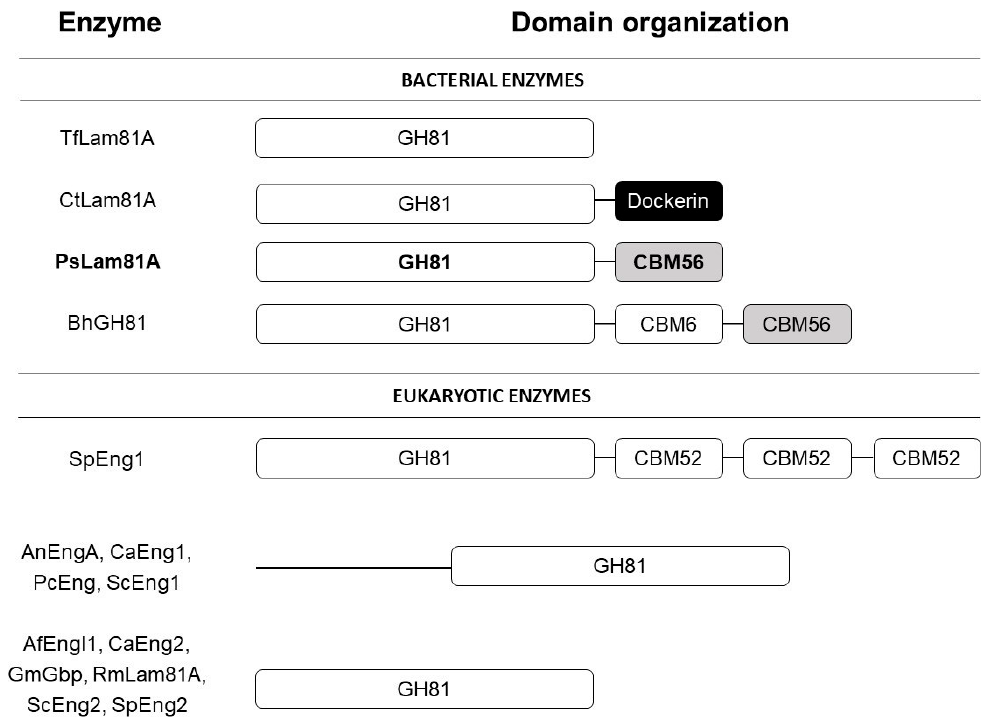
Figure 1. Modular schematics of arrangement of domains in characterized enzymes from GH81 family according to CAZy and InterPro databases. PsLam81A enzyme reported in this study is marked in bold. Domains with a white background are referenced in the CAZy database and are found using a Pfam search. Domains with a grey background are referenced in the CAZy database, but are not found using a Pfam search. Domain with a black background is found using a Pfam search, but is not referenced in the CAZy database. Modular boundaries in the picture are unified for illustration purposes and do not represent the exact sizes of domains.